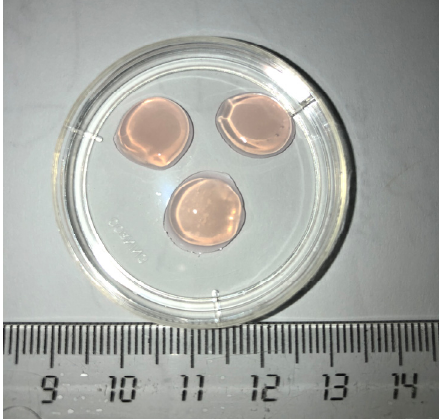
Figure 1. Appearance of the studied biopolymer scaffold.